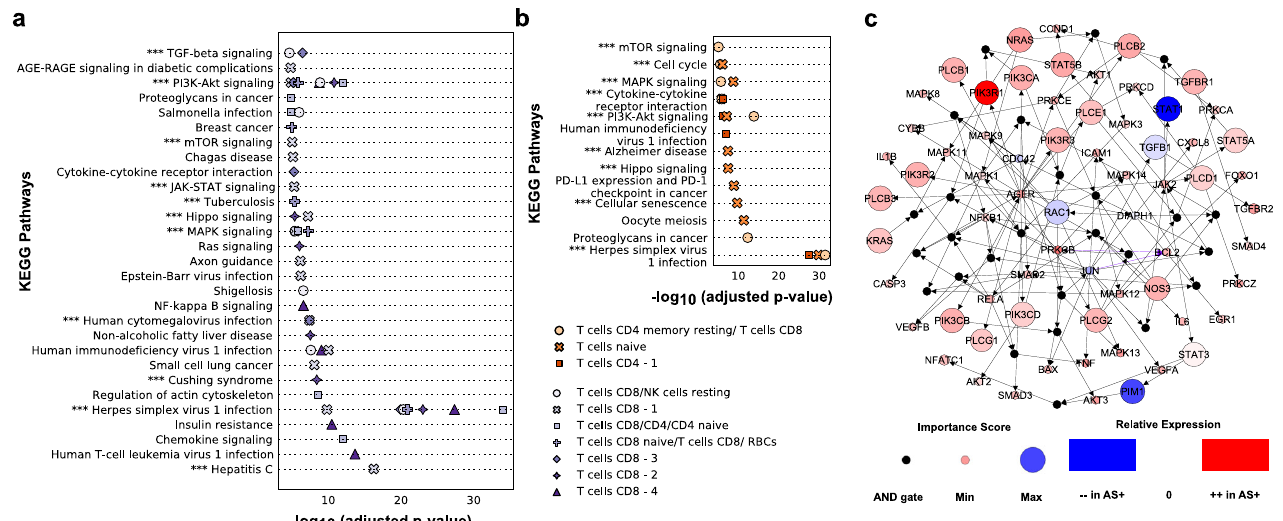
Fig. 3 scBONITA identi fi es dysregulated pathways in T cells derived from AS + and AS − PLWH. Pathways ( y -axis) dysregulated in the AS + vs AS − contrast in PLWH in clusters of a CD8 + T cells and b CD4 + T cells and naïve T cells. Clusters are differentiated by point shape, as shown in the legend. Pathways that have Bonferroni-corrected p -value < 0.01 ( x -axis) and a reduced ERS (see the “ Methods ” section for details) are shown. Pathways labeled with “ *** ” were also dysregulated between cytotoxic T cells ( a ) and T cells ( b ) derived from HIV − subjects and subjects after 1 year of HIV infection 38 ( c ). Network representation of the AGE-RAGE signaling pathway (Bonferroni-corrected p -value < 0.01) in a cluster of CD8 + T cells referred to as CD8 T cells − 1 in Fig. 1a. Small black intermediate nodes indicate that the downstream nodes are controlled by an AND function of the upstream nodes. The size of nodes corresponding to genes is proportional to their importance score calculated by scBONITA. Nodes are colored according to the magnitude of their fold change between the HIV + AS + and HIV + AS − groups. Violet edges indicate inhibition edges and black edges indicate activation